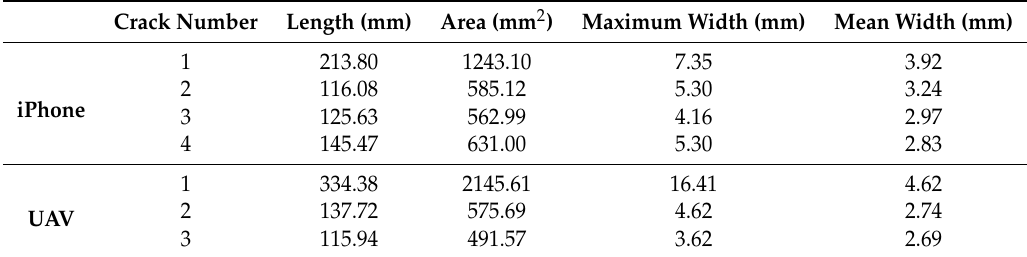
Table 3. Detailed geometric measurements of individual cracks as shown in Figure